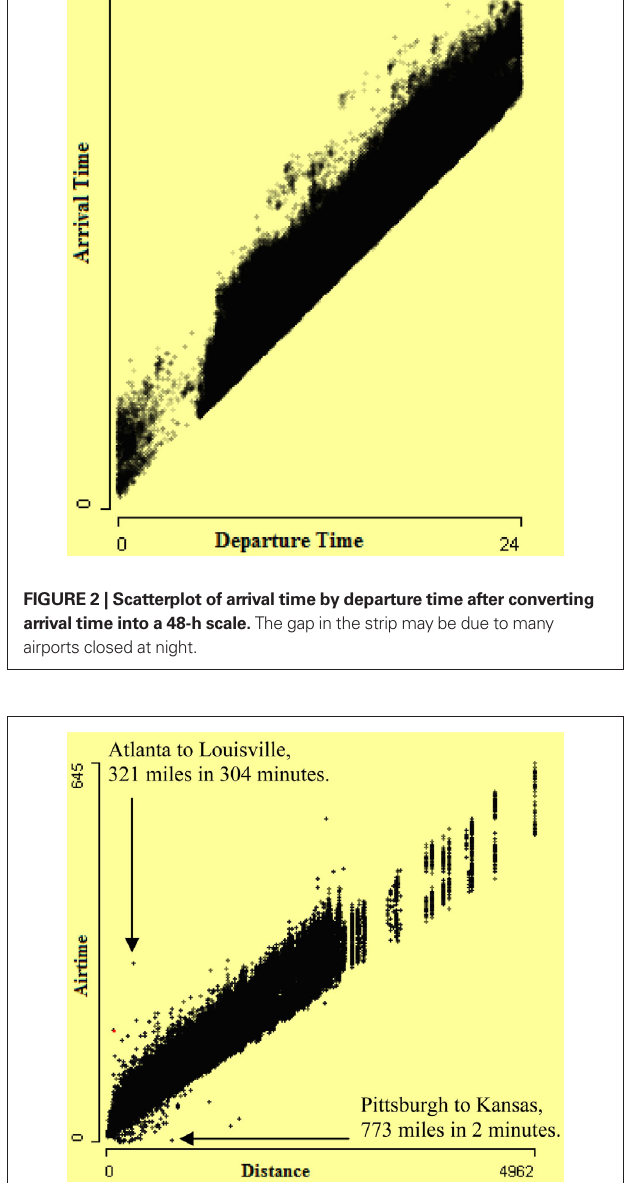
FIgurE 3 | Scatterplot of airtime by distance. It shows some very fast and some very slow flights.